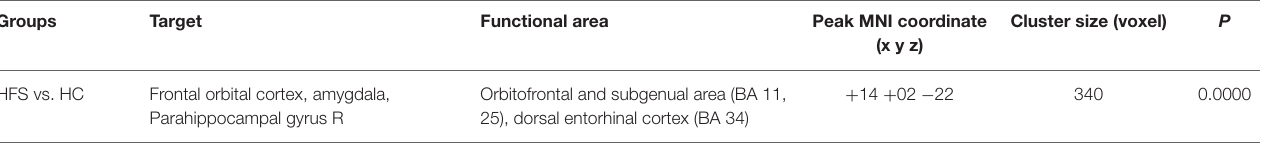
TABLE 3 | Decreased functional connectivity in different groups for seed ROI with the anterior cerebellar network. Groups Target Functional area